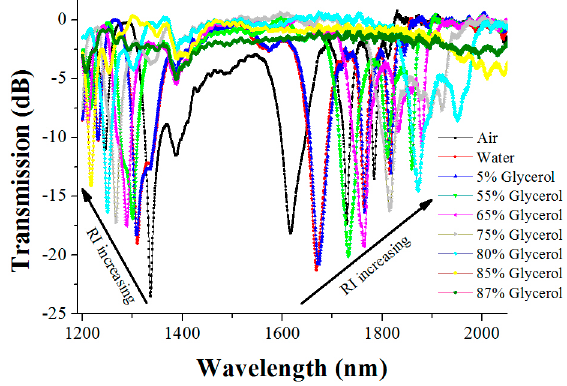
Figure 1. The transmission spectra of the long-period fiber grating (LPFG) in different environment media.